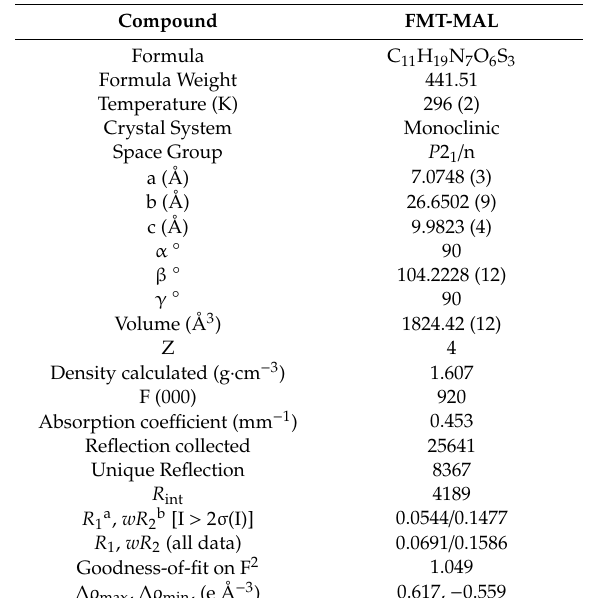
Table 1. Crystal data and structure refinements.